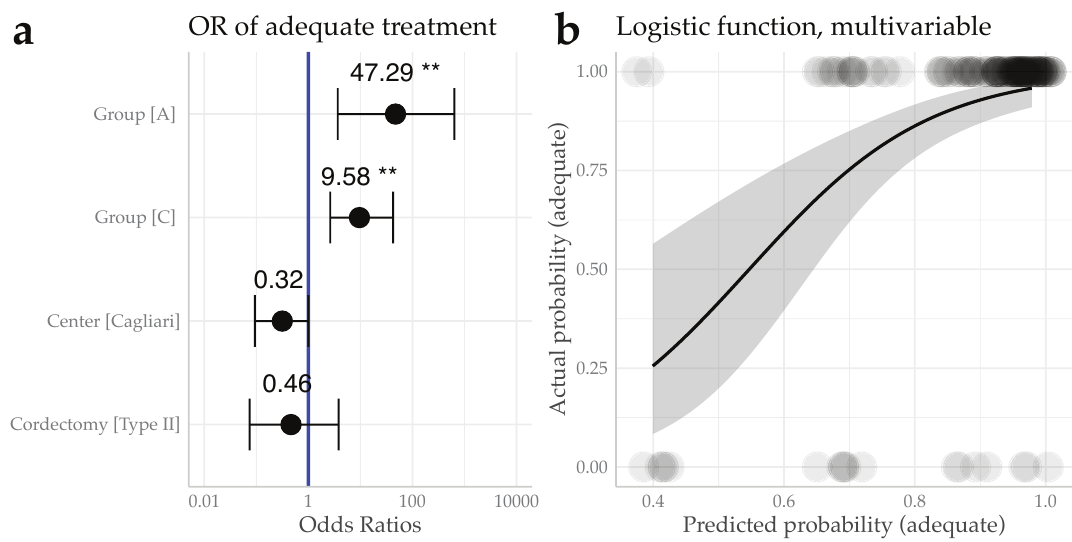
Figure 2. Multivariable logistic regression results. ( a ) Forest plot showing the Odds Ratios (ORs) for the probability of adequate treatment investigating the Group and Center variables. ( b ) Logistic function showing the predicted probability of adequacy of the treatment against the actual one. Legend : OR, Odds Ratio; reference levels for OR estimation: Group B, Genoa Center, and Type I cordectomy; ** p <